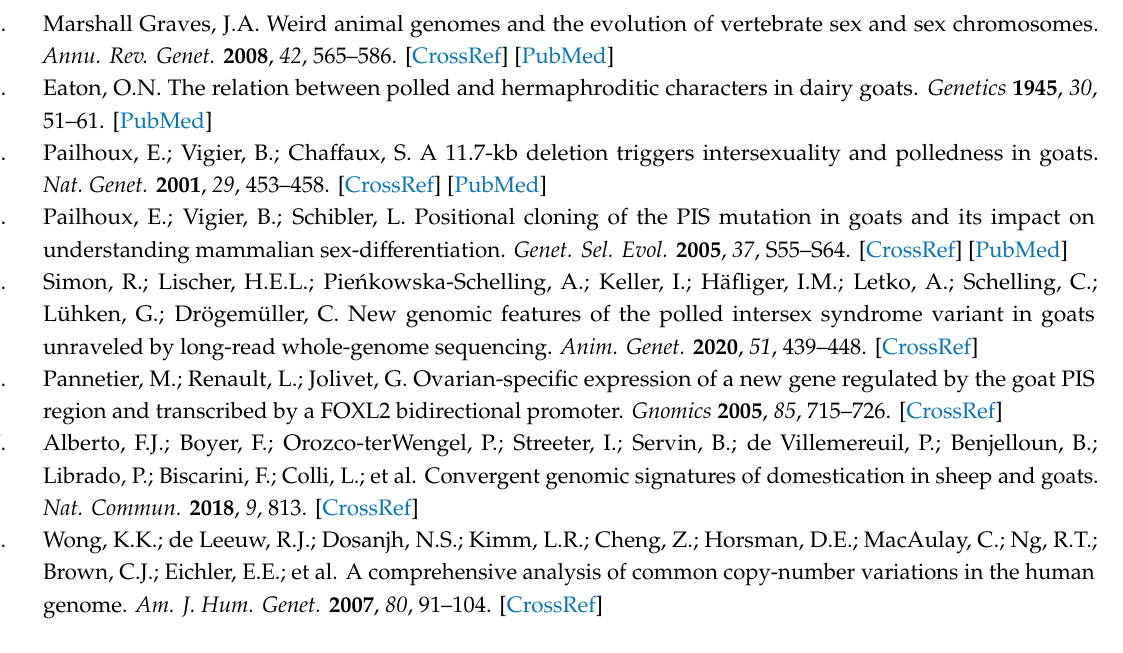
Table S2: The statistics of resequencing samples from 4 Lanzhou large-tailed sheep; Table S3: The statistics of resequencing samples from 8 sheep; Table S4: Chromosome distribution of SNPs in sheep; Table S5: Goat PIS regional positioning on sheep genome (the top 10 score); Table S6: List of genes in the selected overlapping regions by top 1% highest Z(Fst) between intersex sheep and normal sheep (including normal Lanzhou large-tailed sheep and Tan sheep); Table S7: GO term of the candidate genes associated with the intersex; Table S8: List of genes in the selected overlapping regions by top 1% highest Z(Fst) between intersex and normal individuals of Lanzhou large-tailed sheep; Table S9: GO term of the candidate genes associated with the intersex; Table S10: Autosomal distribution of CNVRs in sheep; Table S11: Gene annotation of the candidate CNVRs; Table S12: Functional enrichment analysis of annotated